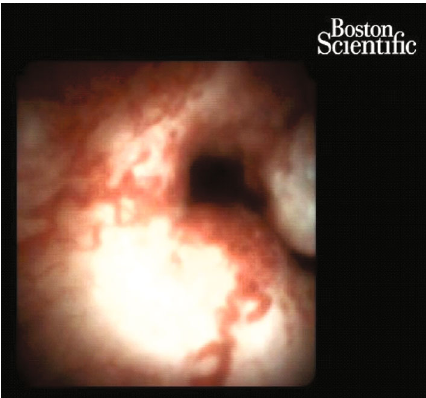
Figure 5: Cholangioscopy (SpyGlass) view of the intraductal-type cholangiocarcinoma.